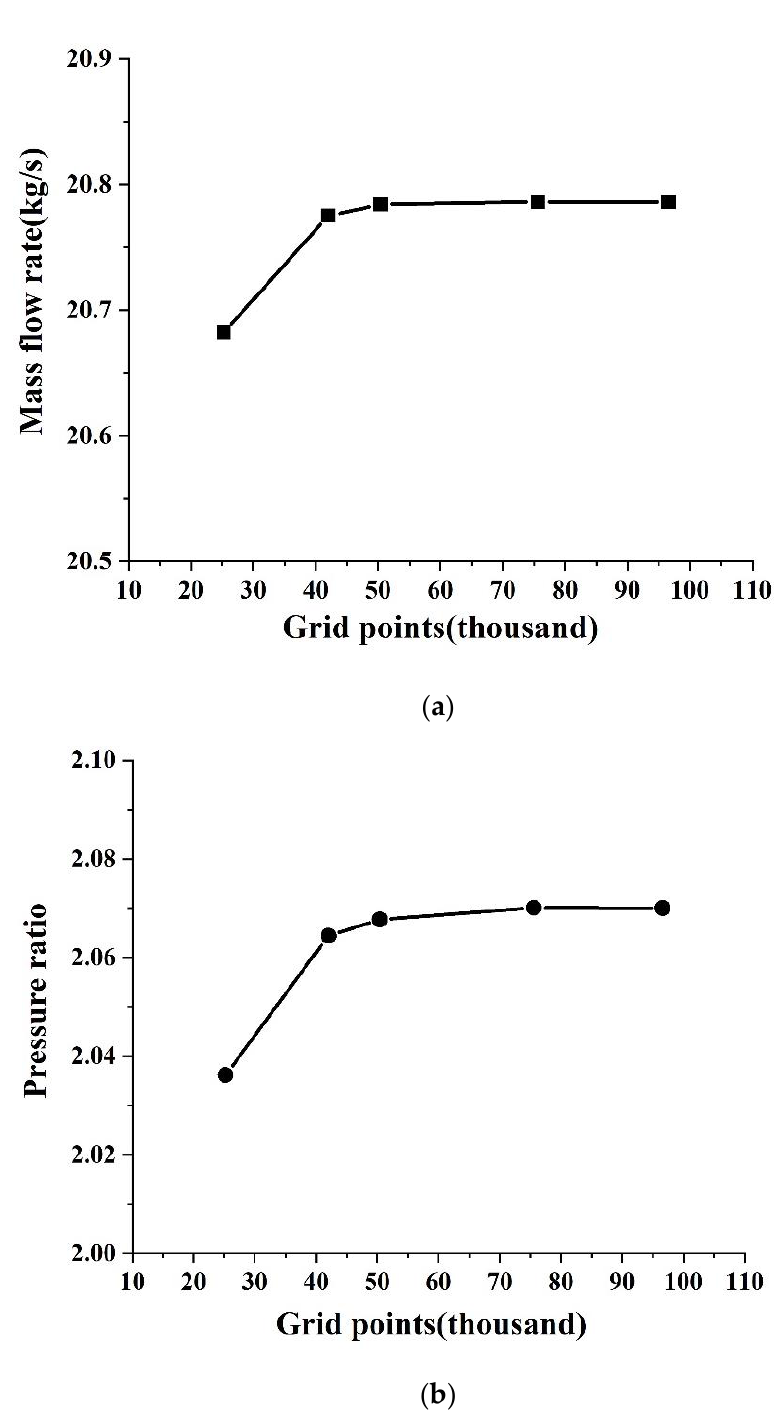
Figure 8. HMNF module computational mesh. ( a ) 3D view and ( b ) Meridional plane view.